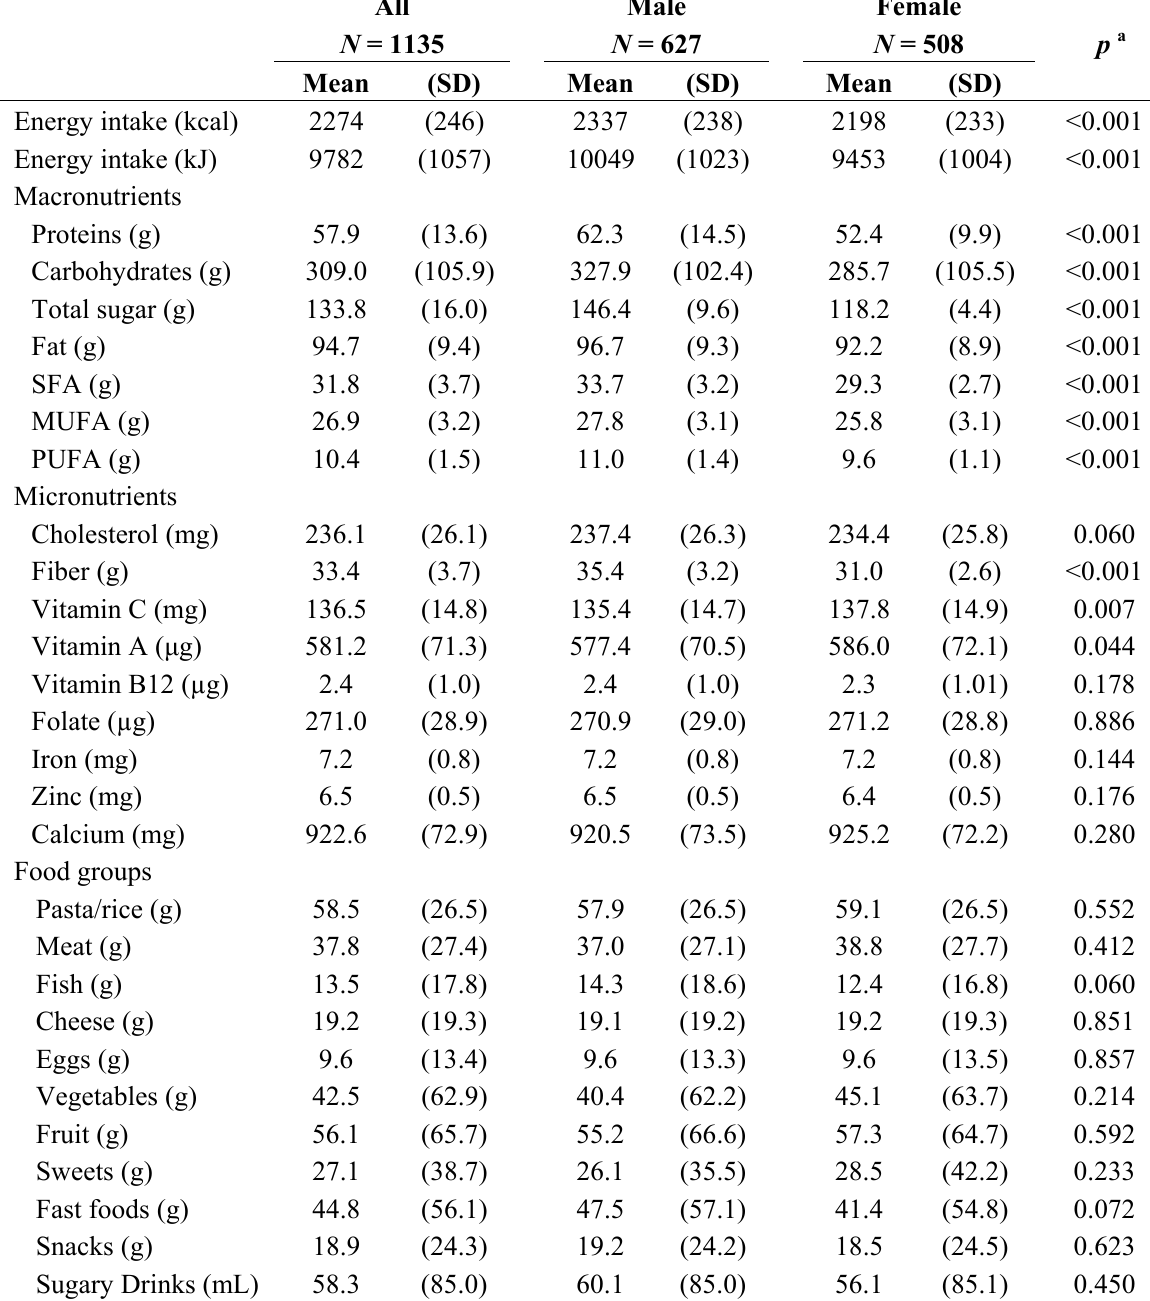
Table 3. Daily energy, nutrients, and food groups intake of the study population, overall and stratified by gender ( n =